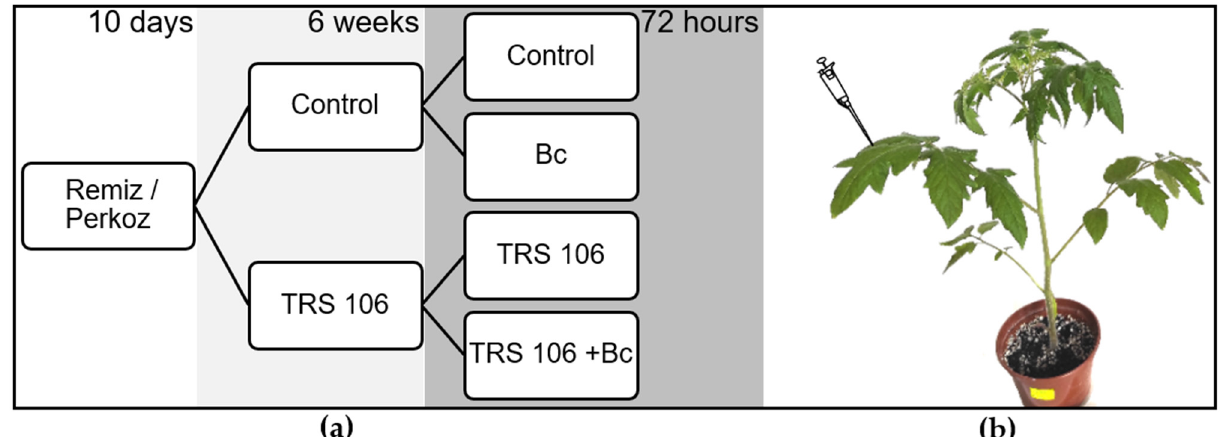
Figure 1. ( a ) Single cultivation scheme; ( b ) procedure of inoculation (Control and TRS 106 plants were inoculated with water drops). In each cultivation, three plants per variant were prepared (3 replicates × 8 variants = 24 plants). Abbreviations: Control, plants grown in the soil without T. virens TRS 106 spores; TRS 106, plants grown in the soil with T. virens TRS 106 spores; Bc, plants grown in the soil without T. virens TRS 106 spores, inoculated with B. cinerea; TRS 106 + Bc, plants grown in the soil with T. virens TRS 106 spores, inoculated with B. cinerea.